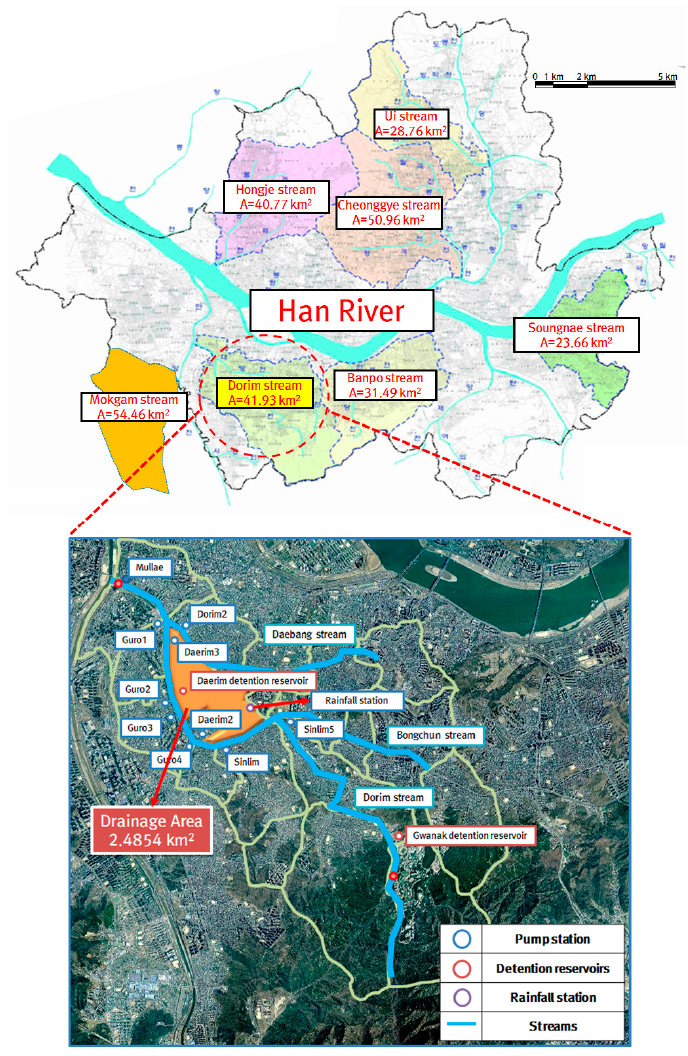
Figure 3. Location and features of the target watershed in Seoul (from Google Earth Imagery © Google Inc., 2015).